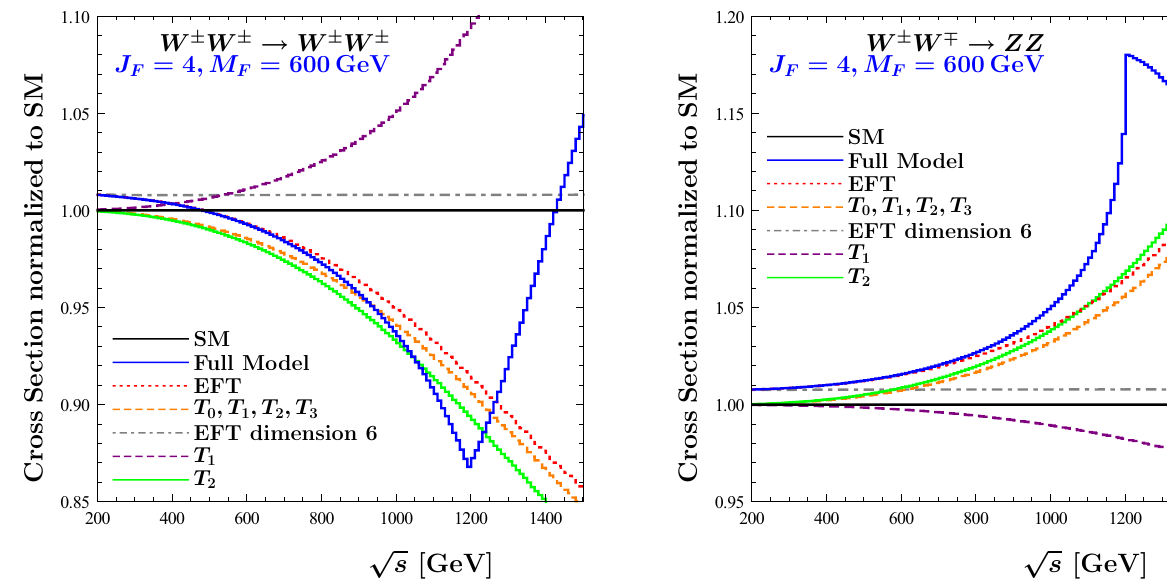
sponding SM cross section in the low energy region. In addition to the curves as in Fig.5, the almost horizontal line at ≈ 1 . 008 represents the result for the EFT at dimension-6 level. See text for